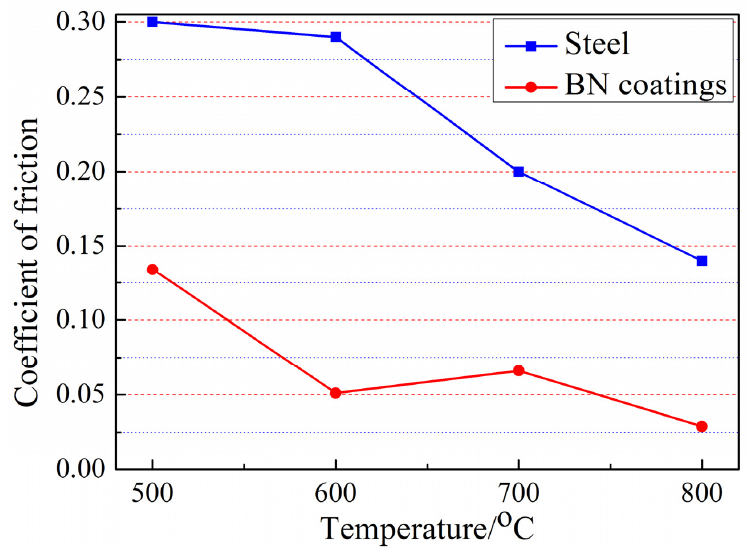
Figure 7. CoF of the uncoated steel and h-BN coatings under different temperatures.